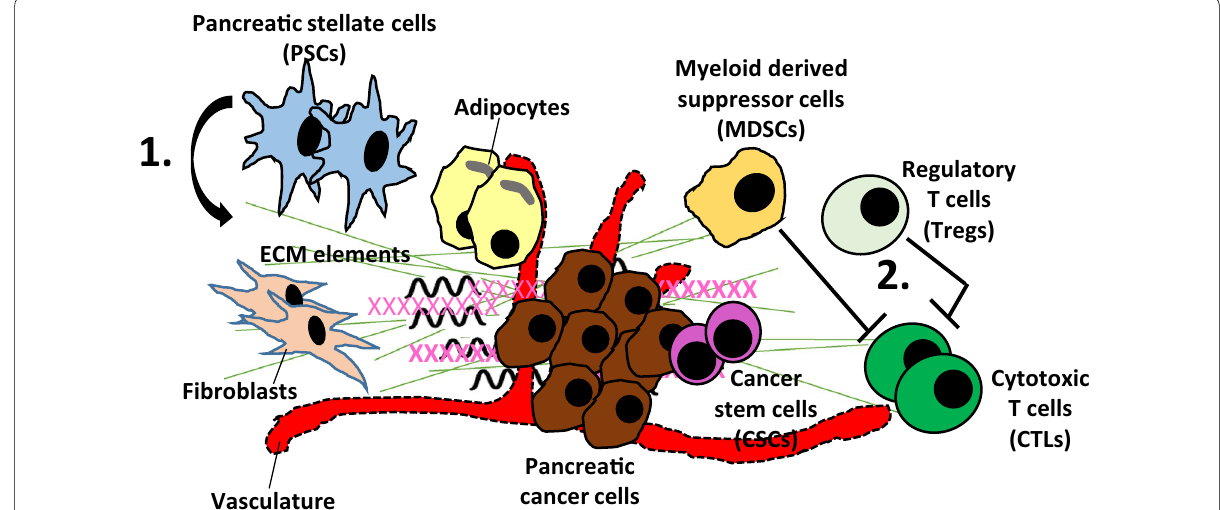
Fig. 1 Unique characteristics of pancreatic cancer microenvironment. Pancreatic cancer stroma is enriched with pancreatic stellate cells (PSCs) that produce excessive amounts stromal elements such as collagens, laminin and fibronectin leading to desmoplasia, a process, which produces a hypovascular microenvironment, impairing local drug delivery, rendering tumors resistant to chemotherapeutics. Cancer stem cells (CSCs), which are known to be multidrug resistant also play a role in chemoresistance [1]. Pancreatic cancer microenvironment is “highly” infiltrated by a variety of immunosuppressive cell types such as myeloid derived suppressor cells (MDSCs) and regulatory T cells (Tregs) that mitigate the effector function of cytotoxic T cells (CTLs), leading to immune evasion. That constitutes an important factor for ineffectiveness of immunotherapies in pancreatic cancer along with the hypoimmunogenic nature of the cancer due to low mutation burden and lack of significant neoantigens